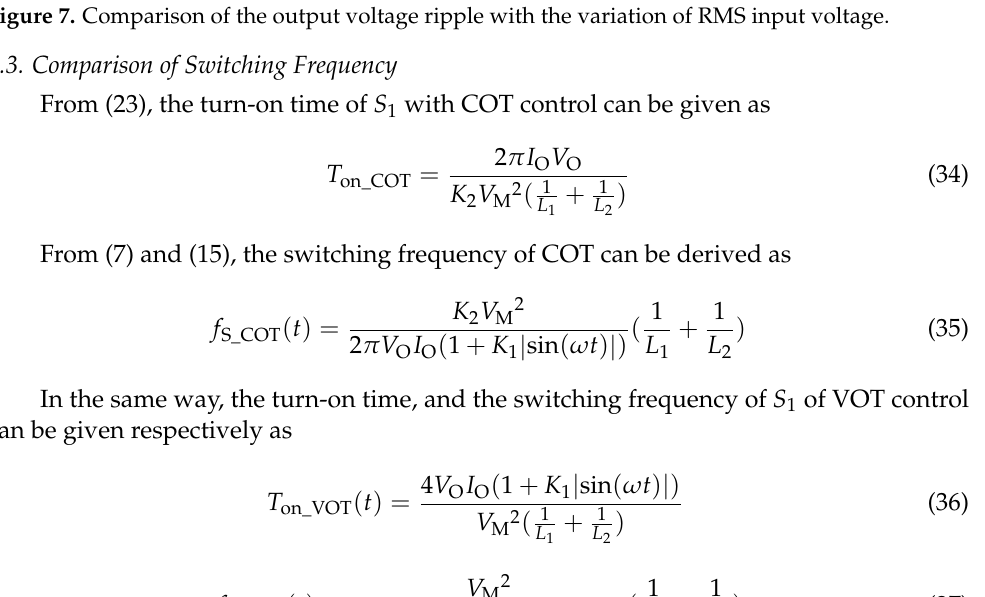
Figure 7. Comparison of the output voltage ripple with the variation of RMS input voltage.